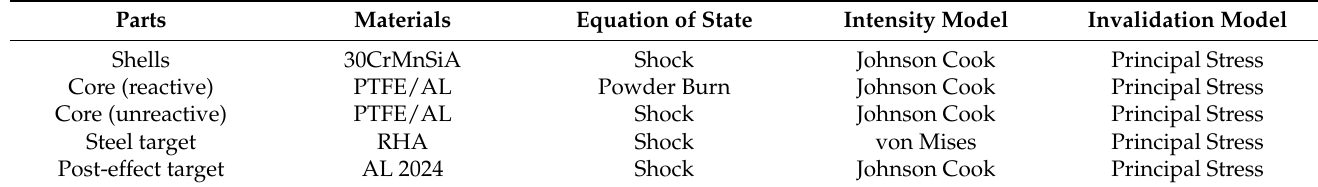
Table 1. Main materials model.